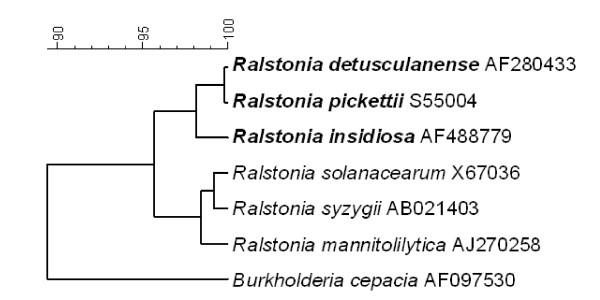
Phylogenetic relationship among Ralstonia detected in the tissue samples from the NEC infants. R. detusculanense, R. pickettii and R. insidiosa did all have more than 99% similarity with the matched Ralstonia tag from the 16S rRNA gene clone library from this study. The bacteria names and the accession numbers are shown.